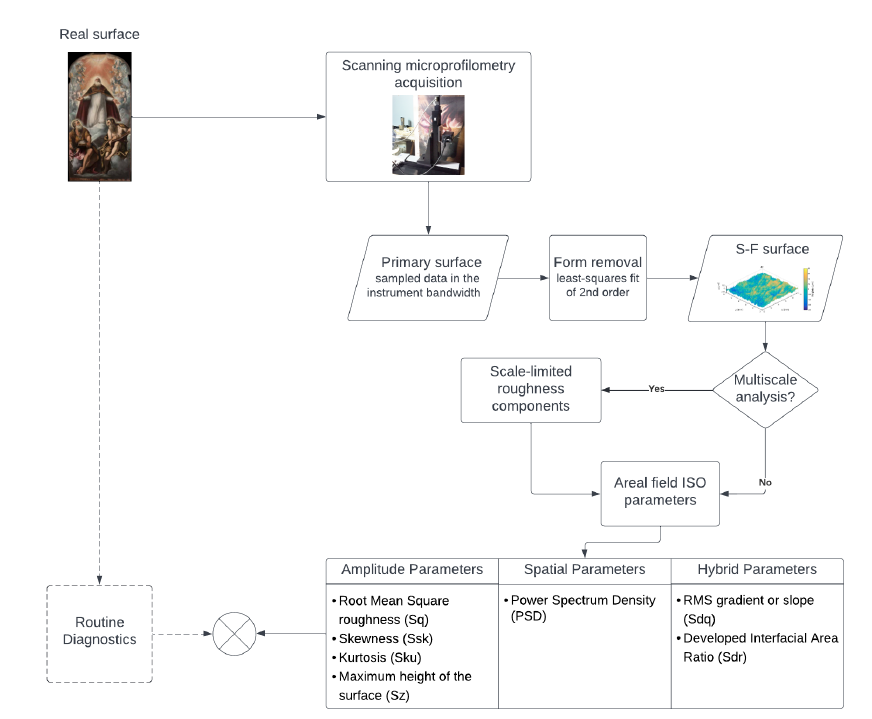
Figure 3. Workflow diagram in the general framework of metrology in cultural heritage. Algorithms are implemented in MatLab environment, starting from the open-source SCOUT toolbox [35]. Scale- limited roughness components separation is not carried out in the present work, but an example of multiscale analysis performed by the authors can be found in